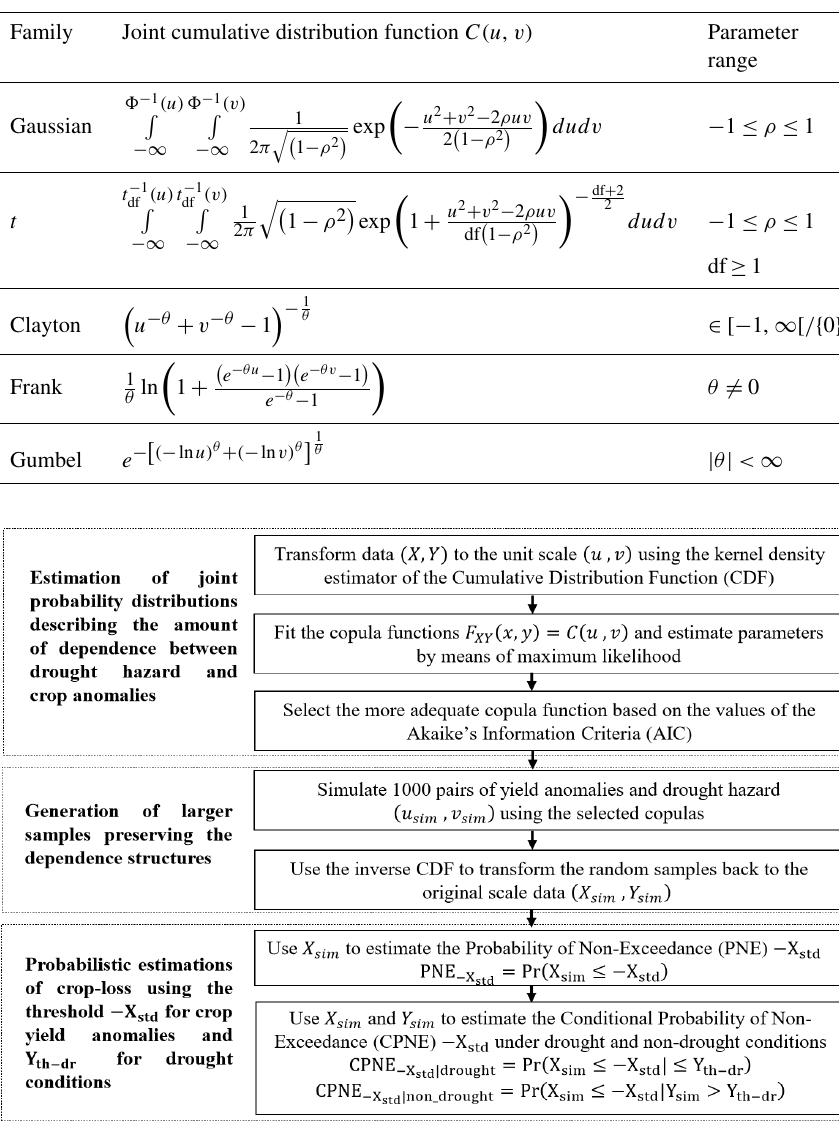
Table 1. Equations of the copula functions, where u and v are univariate variables, (cid:56) − 1 is the inverse of standard Gaussian CDF, t − 1 inverse Student’s t CDF, “df” is the degree of freedom, and ρ and θ are dependence parameters.